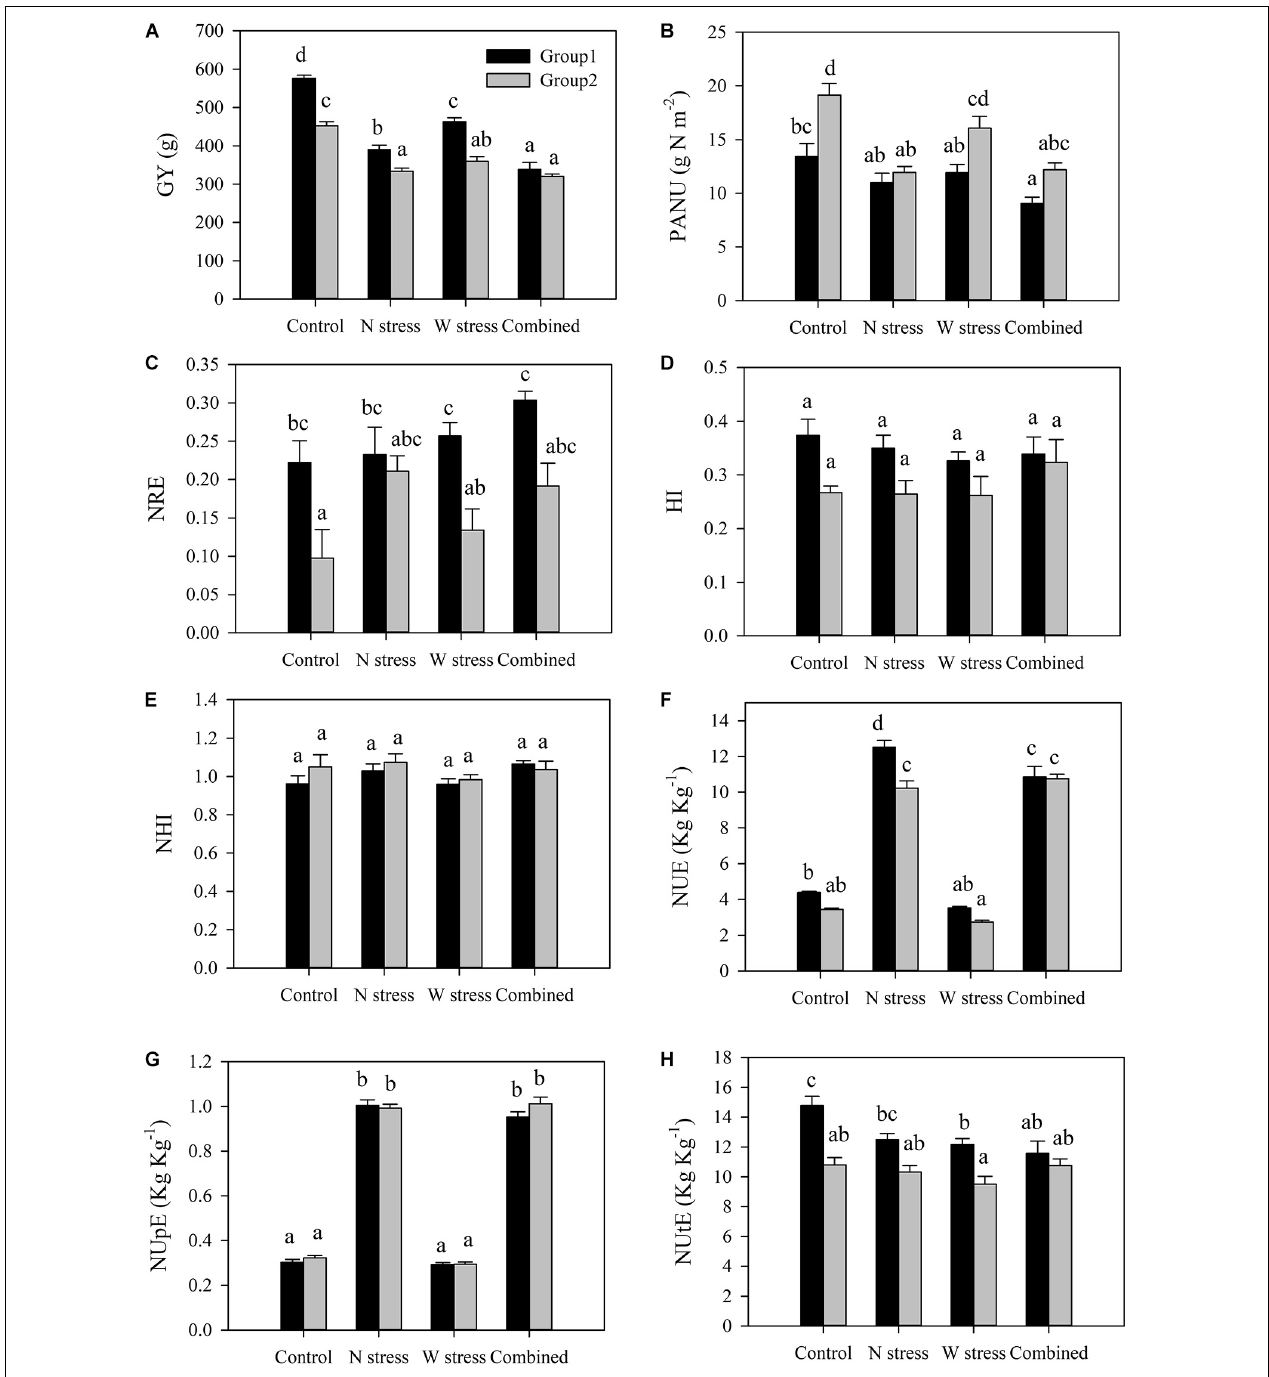
FIGURE 6 | Yield and N-related physiological traits of two groups of genotypes: group 1 (Messapia, Tiziana, Svevo, and Normanno) and group 2 (Russello, Mazzancoio, Cappelli, and Capeiti). Values are means ( n = 5) ± SE. Different letters indicate means that differ significantly according to Tukey’s honest significant difference test at p < 0.05. GY, grain yield (A) ; PANU, post-anthesis nitrogen uptake (B) ; NRE, nitrogen remobilization efficiency (C) ; HI, harvest index (D) ; NHI, nitrogen harvest index (E) ; NUE, nitrogen use efficiency (F) ; NUpE, nitrogen uptake efficiency (G) ; NUtE, nitrogen utilization efficiency (H)